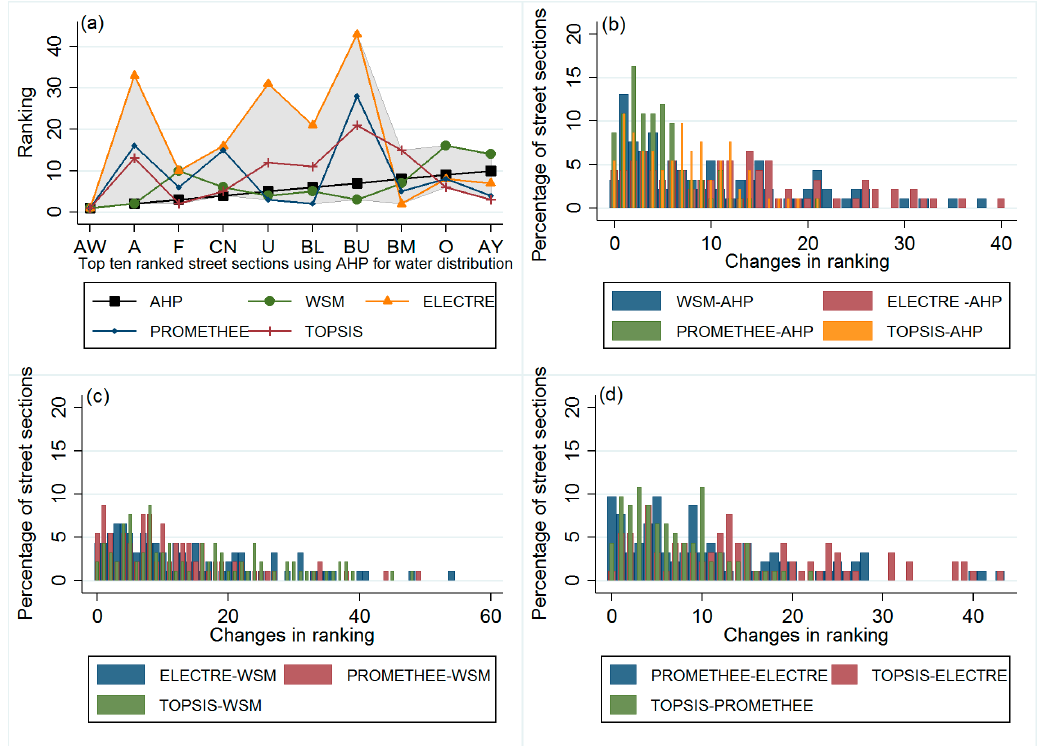
Figure 9. Comparison of the rankings of the water distribution system using the different methods: ( a ) for the 10 top ranked street sections; ( b ) the absolute ranking differences with the AHP; ( c ) the absolute ranking differences with the WSM; and ( d ) the absolute ranking differences with ELECTRE and PROMETHEE. Table 6. Standard deviation σ of the water distribution network ranking between the different used methods.